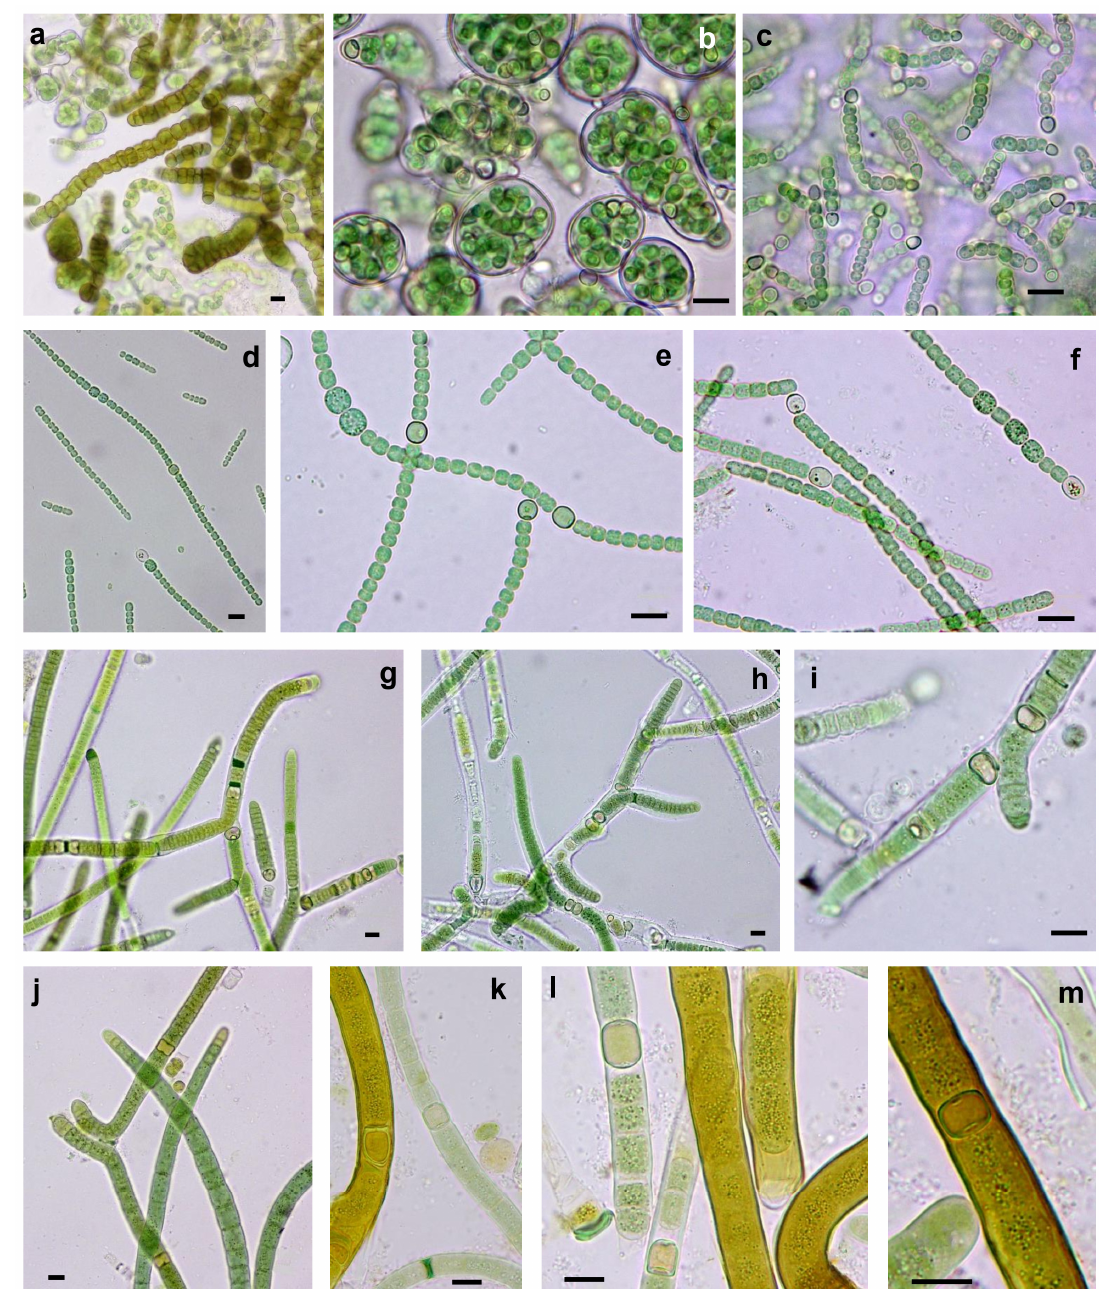
Figure 5. Microphotographs of heterocystous cyanobacterial strains. ( a ) and ( b ) Nostoc commune LSB51, ( c ) N. commune LSB84, ( d ) and ( e ) Trichormus sp. SBC124, ( f ) Trichormus sp. SBC125, ( g ), ( h ) and ( i ) Tolypothrix distorta LSB87, ( j ), ( k ), ( l ) and ( m ) Scytonema hyalinum MAR43. Scale bar 10 μ m.